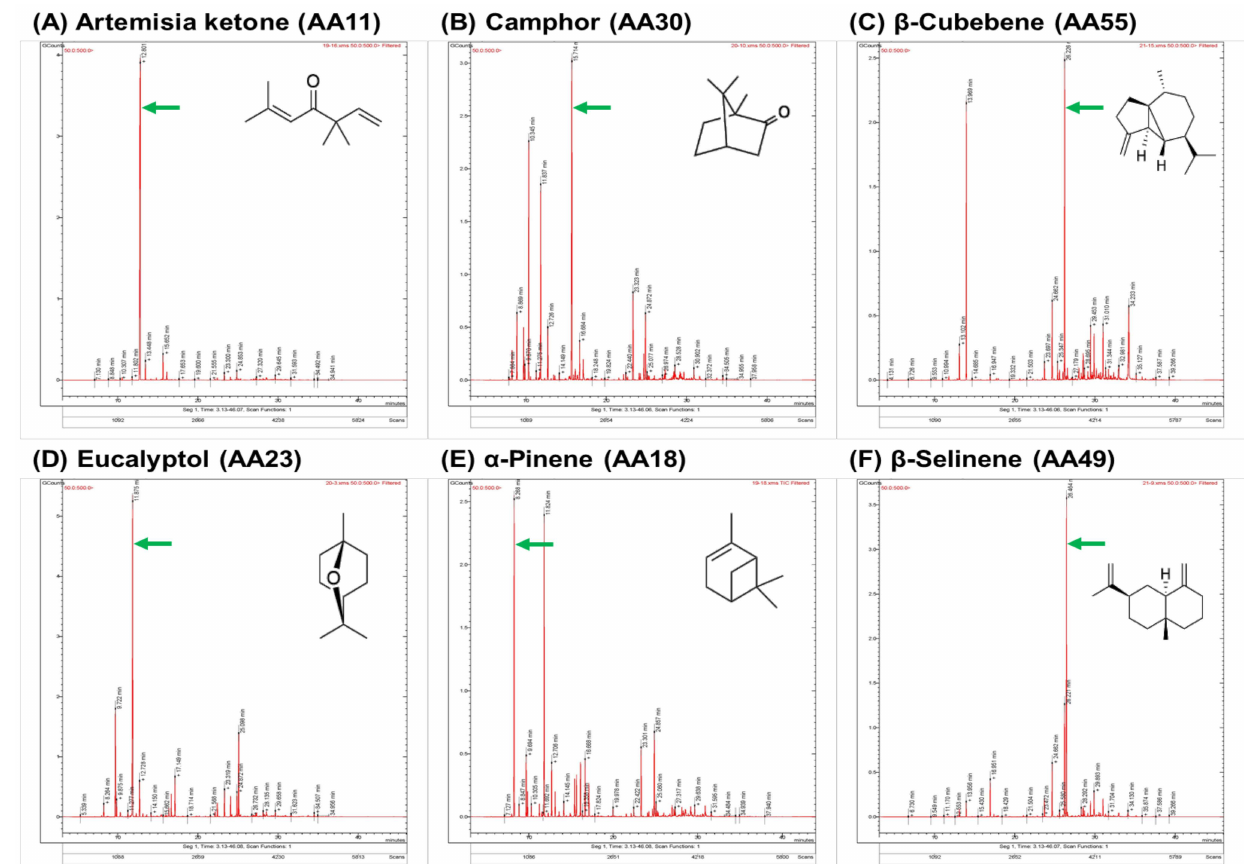
Figure 2. The GC-MS chromatograms of six representative chemotypes of Korean A. annua indi- viduals. The peak of major components was marked with a green arrow: ( A ) artemisia ketone; ( B ) camphor; ( C ) β -cubebene; ( D ) eucalyptol; ( E ) α -pinene; ( F ) β -selinene. The sample names of re- spective chromatograms: AA11, Hongcheon; AA30, Pyeongtaek; AA55, Gwangju; AA23, Chuncheon; AA18, Danyang; AA49,